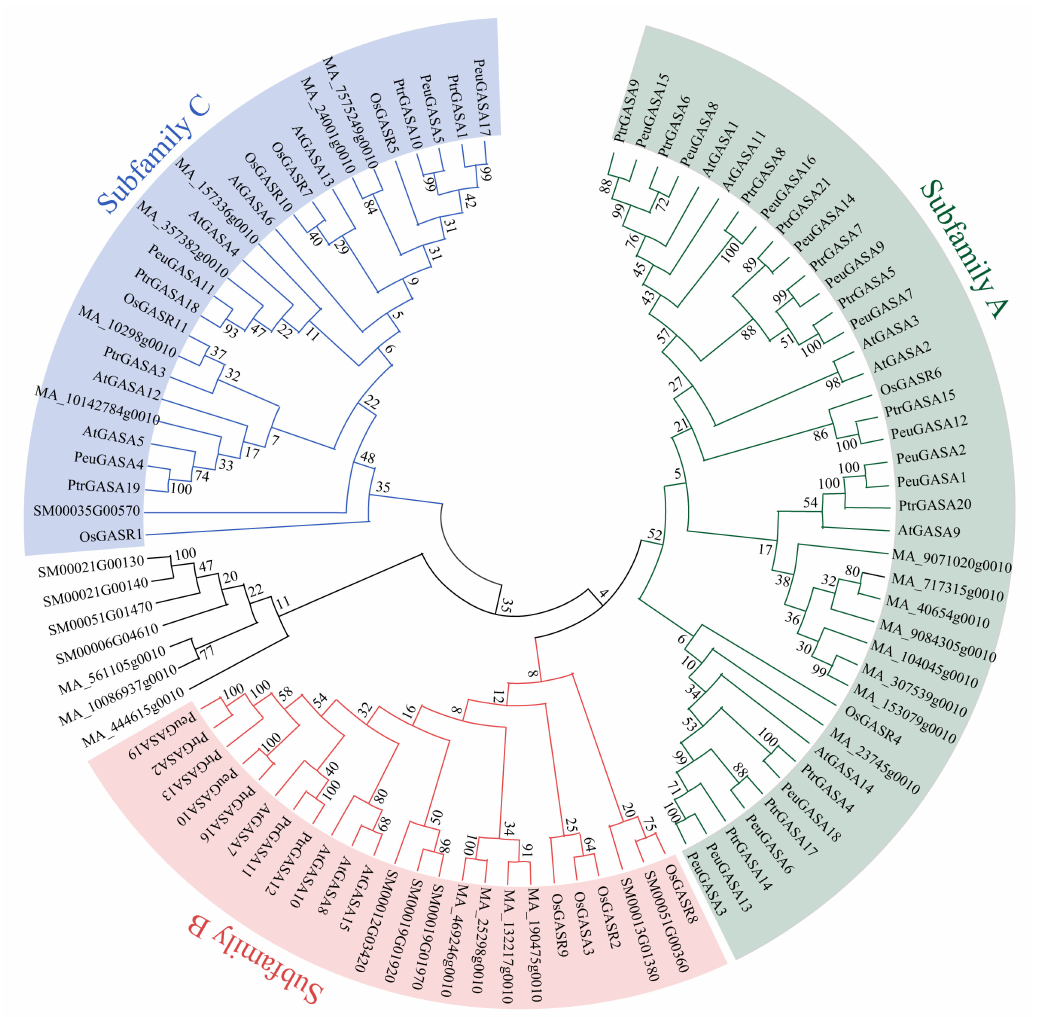
Figure 2. Neighbor-Joining phylogenetic tree of GASA domains. The 97 conserved GASA domains of GASAs in sequenced plants, Selaginella moellendorffii , Picea abies , Oryza sativa ssp. japonica , Arabidopsis thaliana , Populus trichocarpa , and Populous euphratica were analyzed. The tree was divided into three phylogenetic subgroups, which were shown in different